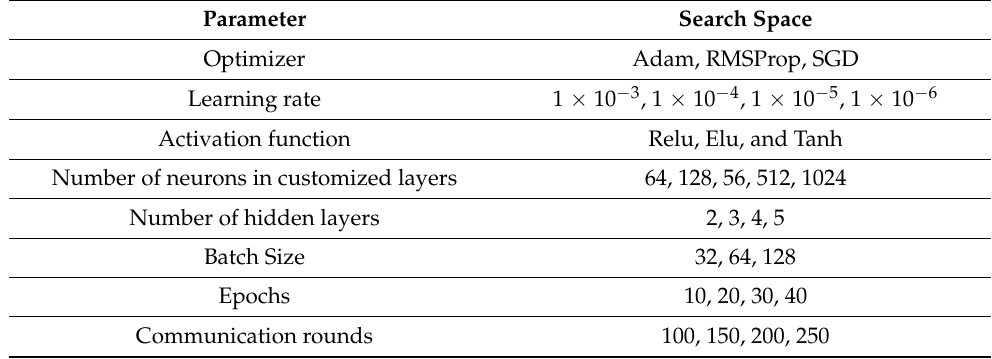
Table 3. Hyper-parameters and their search spaces.